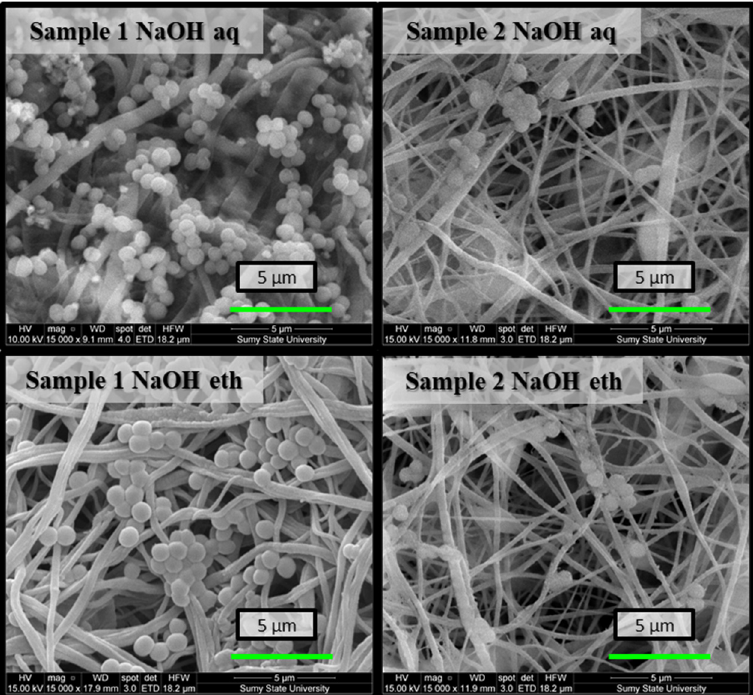
Figure 6. SEM images of bacterial biofilms on the surfaces of electrospun nanofibrous membranes after 8 h co-cultivation in the bacterial suspension of S. aureus .